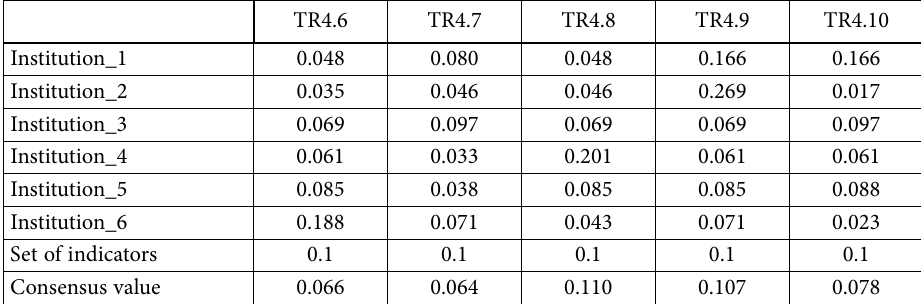
Table 6. Transparency-indicator weighting. Budgeting and economic information disclosure block.